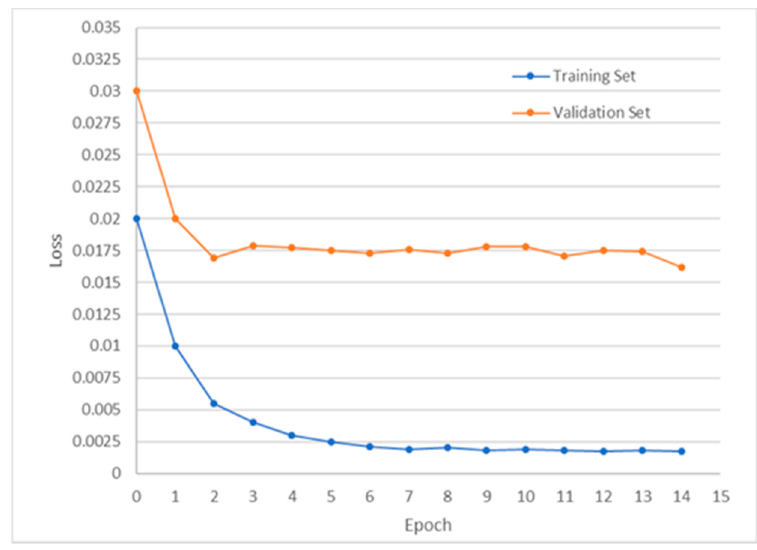
Figure 14. Loss plot of model 13 during training.